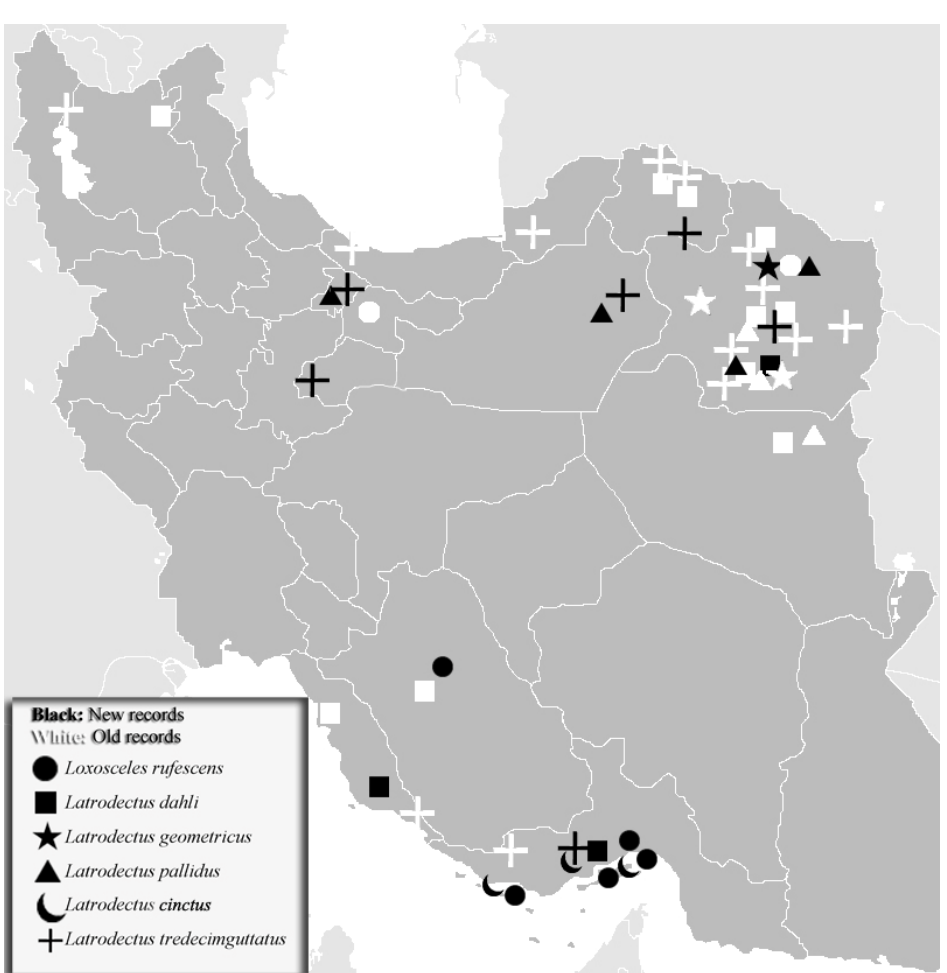
F IGURE 5. Distribution map of Loxosceles rufescens and Latrodectus spp., based on new (black) and old (white)